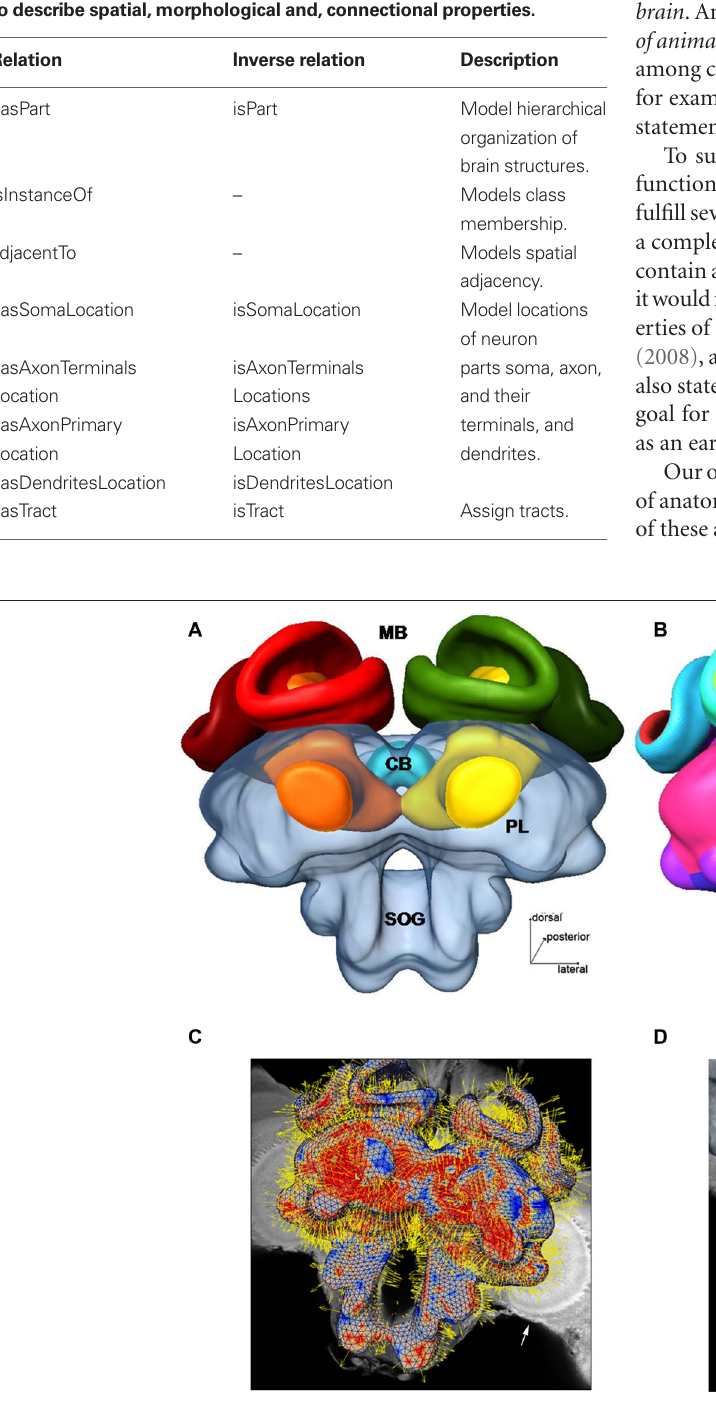
blue color indicates the displacement vectors point outwards, red means they point inwards. The white arrow indicates one orthogonal slice of the 3D confocal image stack to which the model adapts. (D) A protocerebral region close to the esophagus is shown to demonstrate matching of the SSM (in transparency) to the corresponding gray-value confocal image. The red line marks the intensity profile (length 100 μm) along the vertex normals (adapted from Lienhard, 2008; Singer, 2008) for (A) : see also S4 movie in supplementary material.